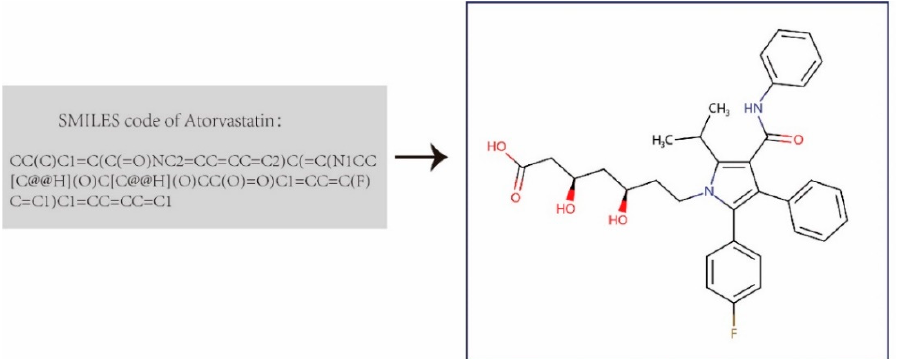
Figure 1. Drug molecular graph transformed from drug SMILES. GNN-DDI learns the drug representation features directly from their chemical molecu- lar structure graphs by graph convolution network. In order to compare those features with other molecular structure fingerprint features and features from their biological properties, we also extracted the ATC (Anatomical Therapeutic Chemical Classification) and DBP (Drug Binding Proteins) from DrugBank, and utilized the PubChem fingerprint and the MACCSkeys fingerprint (Molecular ACCess System keys fingerprint [45] to convert the SMILES of drugs into the 881-dimesion and 166-dimension binary vector, respectively. Each bit in the vector indicates the occurrence or non-occurrence of a pre-defined substructure according to Pubchem fingerprints or MACCSkeys fingerprints. ATC codes are released by the World Health Organization [46], and they categorize drug substances at different levels according to organs they affect, application area, therapeutic properties, chemical, and pharmacological properties. It is generally accepted that compounds with similar physicochemical properties exhibit similar biological activity. To feed the 7-bit ATC code used drug-binding protein (DBP) data [47], containing 899 drug targets and 222 non-target proteins. Similarly, each drug was represented as a binary DBP-based feature vector, with each bit indicating whether the drug binds to a specific